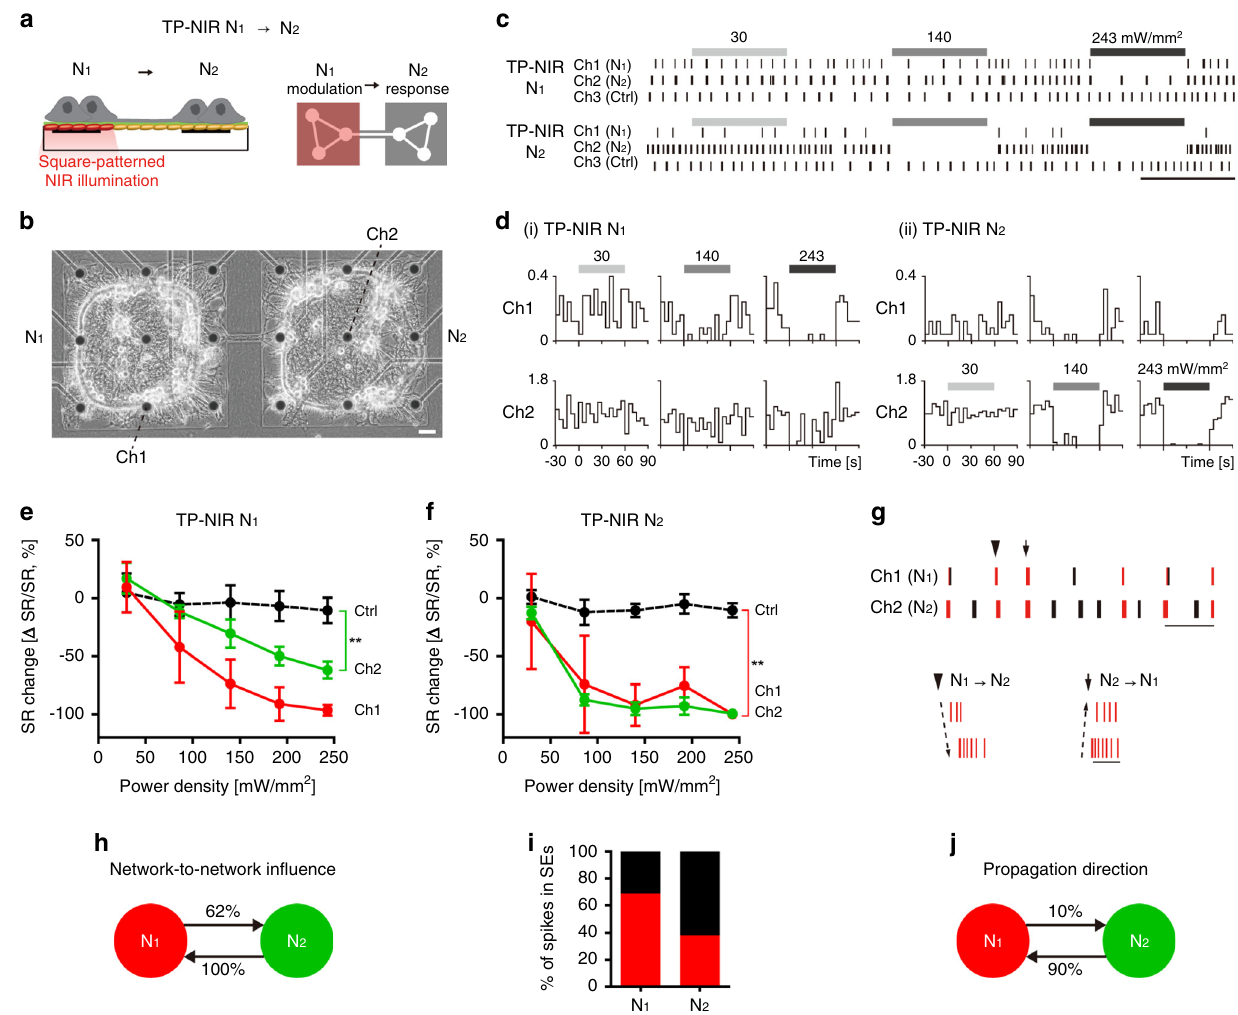
Fig. 5 Thermoplasmonic neuromodulation and estimation of network connectivity. a Thermoplasmonic NIR stimulation (TP-NIR) by square-patterned illumination. To estimate the network-to-network in fl uence of N 1 on N 2 (TP-NIR N 1 → N 2 ), N 1 spiking activity was suppressed by localized thermoplasmonic neural stimulation. b Phase-contrast image of tested network. Agarose micropatterns were 500 μ m by 500 μ m with a spacing of 100 μ m. Scale bar: 50 μ m. c Representative raster plots and ( d ) perievent histograms before, during, and after stimulation with different power densities (30, 140, 243 mW/mm 2 ). TP-NIR N 1 and TP-NIR N 2 indicate the stimulation of N 1 and N 2 , respectively. Scale bar: 1 min. x -axis: second. y -axis: Hz (spikes/sec). e Spike rate change against power density for TP-NIR N 1 . The black line (Ctrl) shows rate change in control groups (5 electrodes in unconnected networks) in the same MEA. n = 5 trials for each network. Data are presented as mean ± SD. Two-sided Mann – Whitney test for the values of each network compared with those of control groups at the highest power density (** p < 0.01); p = 0.0079. f Spike rate change against power density for TP-NIR N 2 . The black line (Ctrl) shows rate change in control groups (5 electrodes in unconnected networks) in the same MEA. n = 5 trials for each network. Data are presented as mean ± SD. Two-sided Mann – Whitney test for the values of each network compared with those of control groups at the highest power density (** p < 0.01); p = 0.0075. g Raster plots of spontaneous activity and examples of inter-network synchronized events (SEs) that spikes propagate from N 1 to N 2 (arrowhead) and from N 2 to N 1 (arrow). Red timestamps represent spikes that participated in SEs. Scale bar: 10 s and 500 ms. h Network-to-network in fl uence estimated by thermoplasmonic neuromodulation. i Association degree in inter-network SEs. Red is the percentage of spikes participated in SEs. j Proportion of propagation direction within individual SEs. 106 detected SEs were analyzed. Source data are provided as a Source Data fi